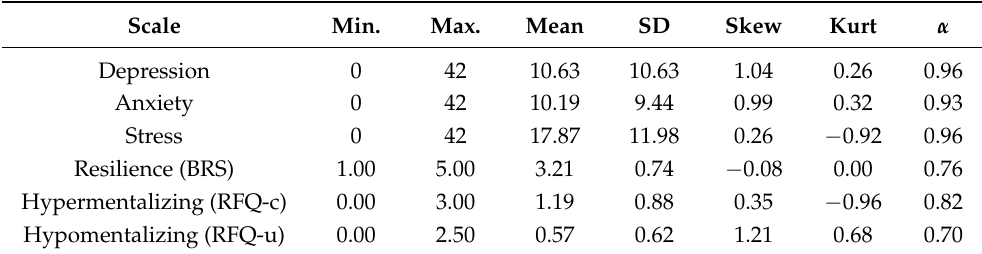
Table 2. Descriptive statistics of used